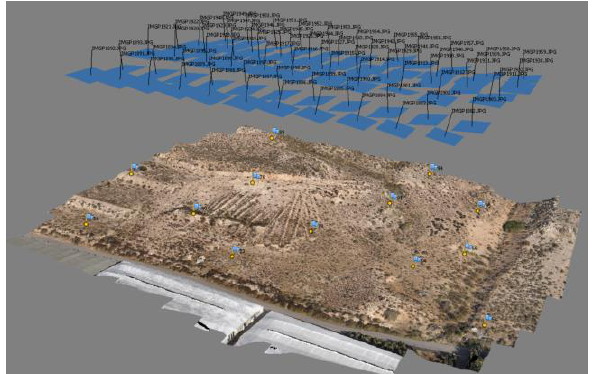
Figure 5. Unoriented and unscaled 3D photogrammetric block resulting from bundl ajustment process. Position and orientation of the 66 images are represented by blue squared and control point by flags After that, the UTM Universal Coordinate System was assigned to the photogrammetric model based on the target points identified in the images as control points.